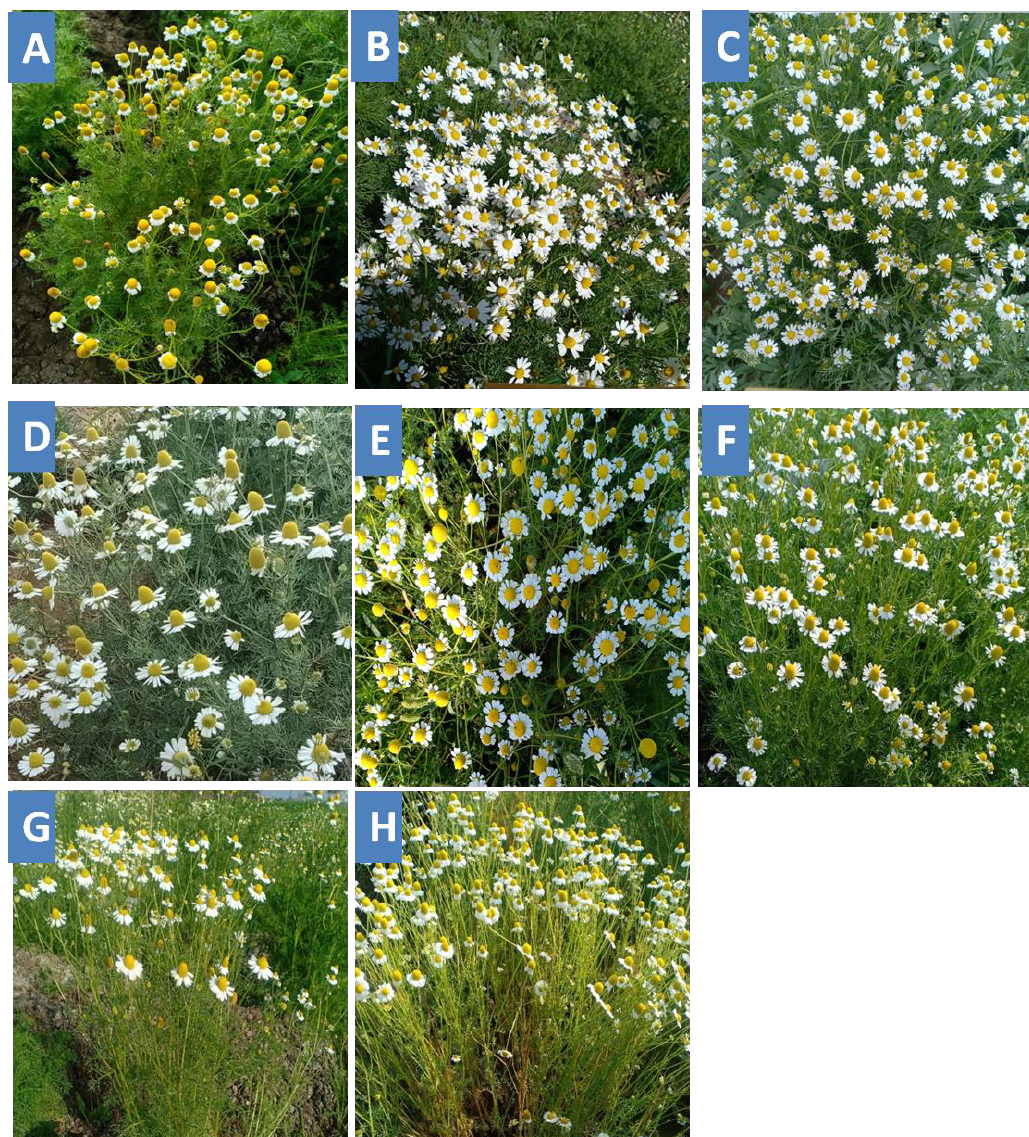
Figure 1. Phenotype of the selected five promising mutants and their control plants. A . Control plant of Benysuef population. B . BHNOF 4-3-1 mutant. C . B/HNOF 8-4-2 mutant. D . Control plant of Fayoum population. E . F/HNOF 3-1-1 mutant. F . F/LF5-2-1mutant. G . Control plant of Menia population. H . M/HNOF 4-1-1 mutant.